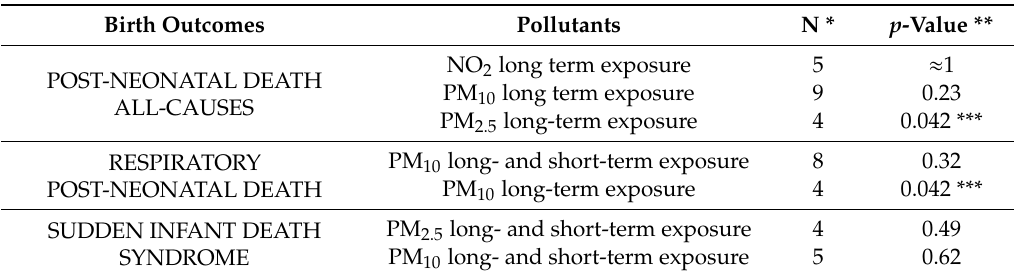
Table 4. Begg’s test on the e ff ect of air pollutants on infant